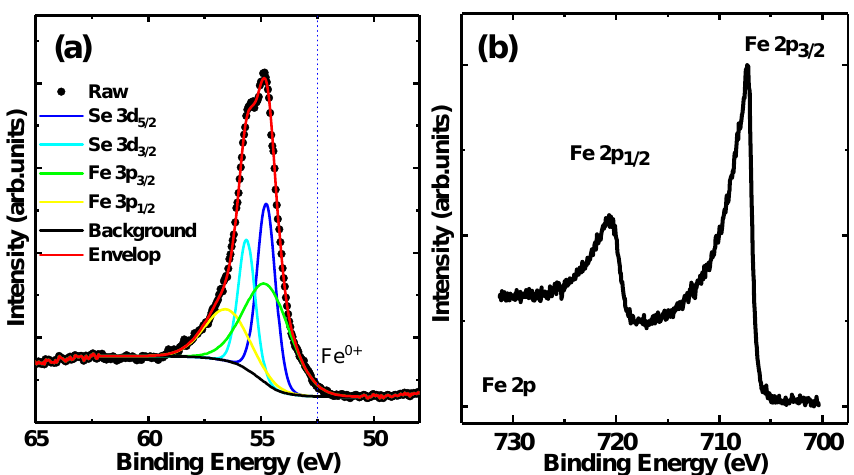
Figure 4. Core-level XPS spectra of ( a ) Se 3 d along with its fitted components (solid lines) and ( b ) Fe 2 p spectra of FeSe films.